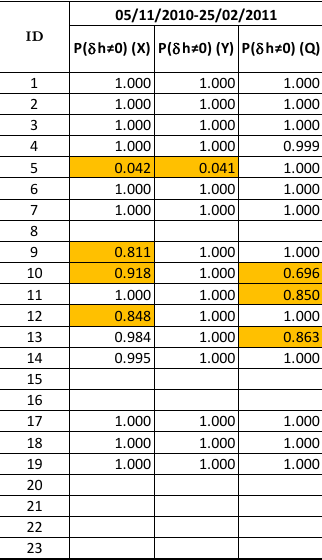
Table 11. Results of Bayesian analysis with prior data μ =